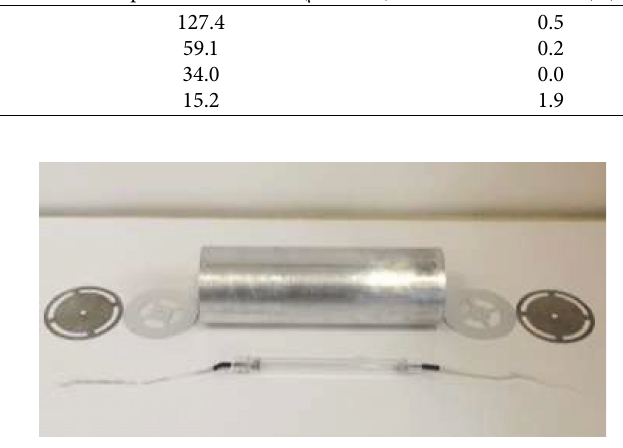
Figure 4: Parts of the manufactured